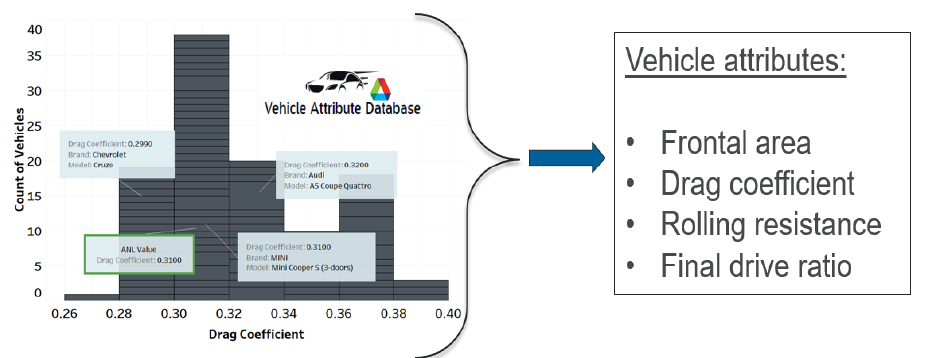
Figure 3. Vehicle attribute selection for different vehicle combinations.